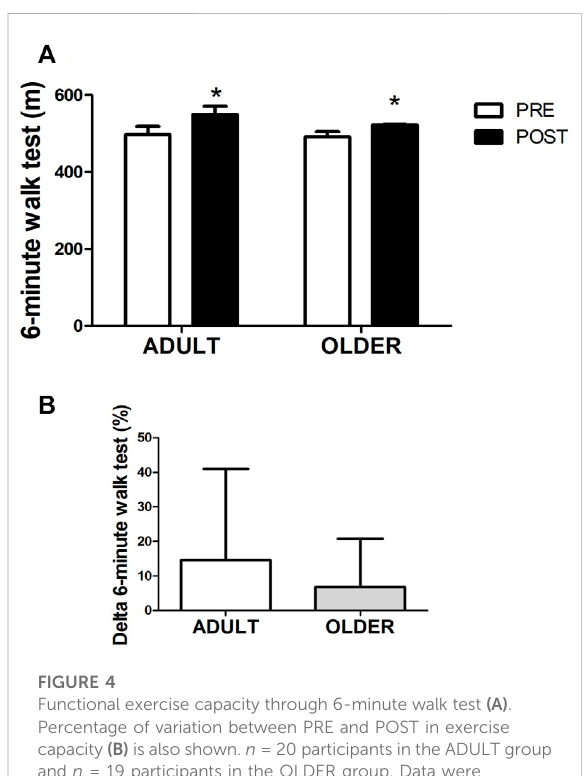
FIGURE 4 Functional exercise capacity through 6-minute walk test (A) . Percentage of variation between PRE and POST in exercise capacity (B) is also shown. n = 20 participants in the ADULT group and n = 19 participants in the OLDER group. Data were analyzed using a repeated-measures ANOVA (A) and an independent samples t-test (B) . * p < 0.05 (time effect).